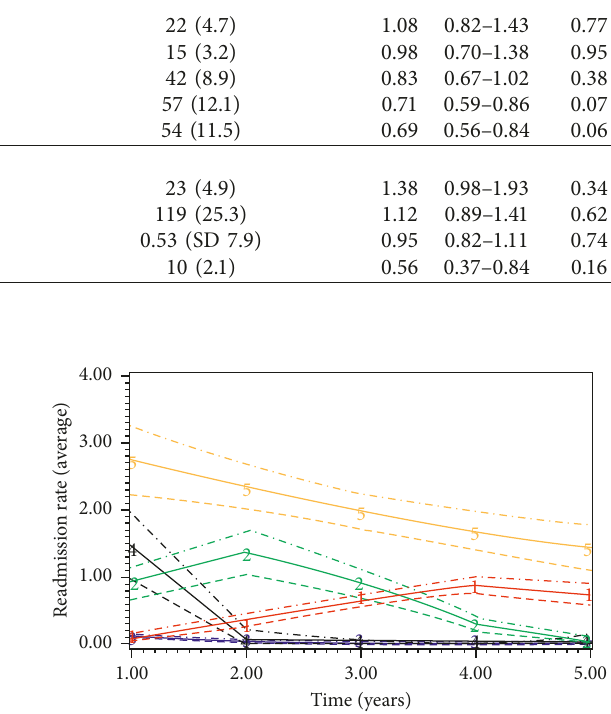
Figure 5: Subgroups among ruptured AAA patients with EVAR repair and their trajectories of unplanned readmission rates (the horizontal axis starts with annual readmission rate at year one, and the dotted lines represent 95% confidence intervals for each subgroup).